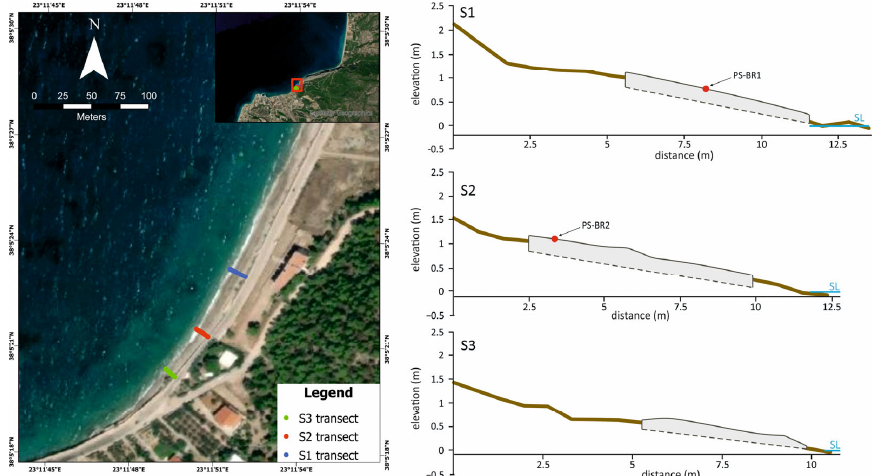
Figure 3. Location of the three transects performed on the beachrock slabs on the left figure. On the right is the schematic representation of beachrock cross sections and OSL sample points (red circles).